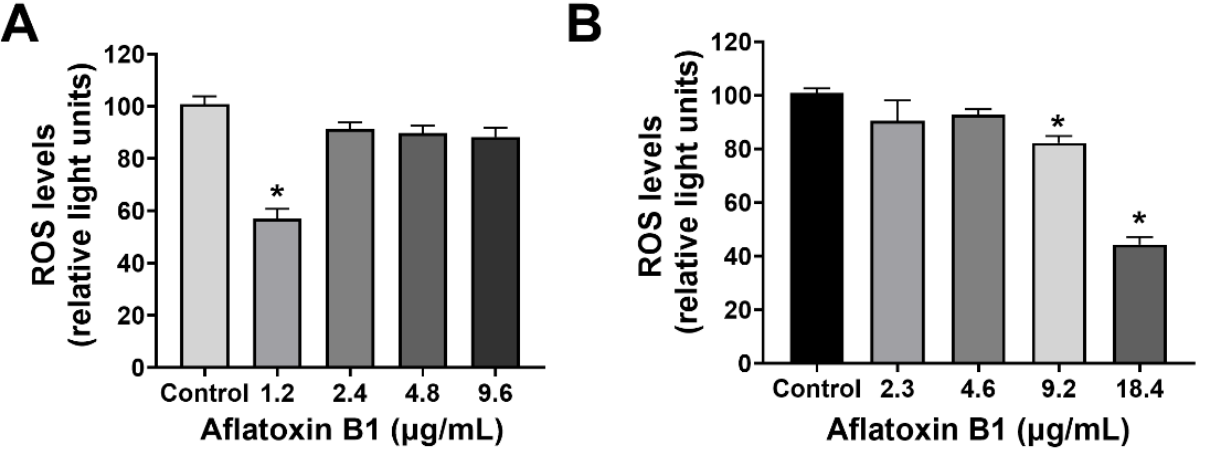
Figure 2. ROS levels of MCF7 ( A ) and MCF10A ( B ) cells after treatment with aflatoxin B1. * p < 0.05 compared to control.